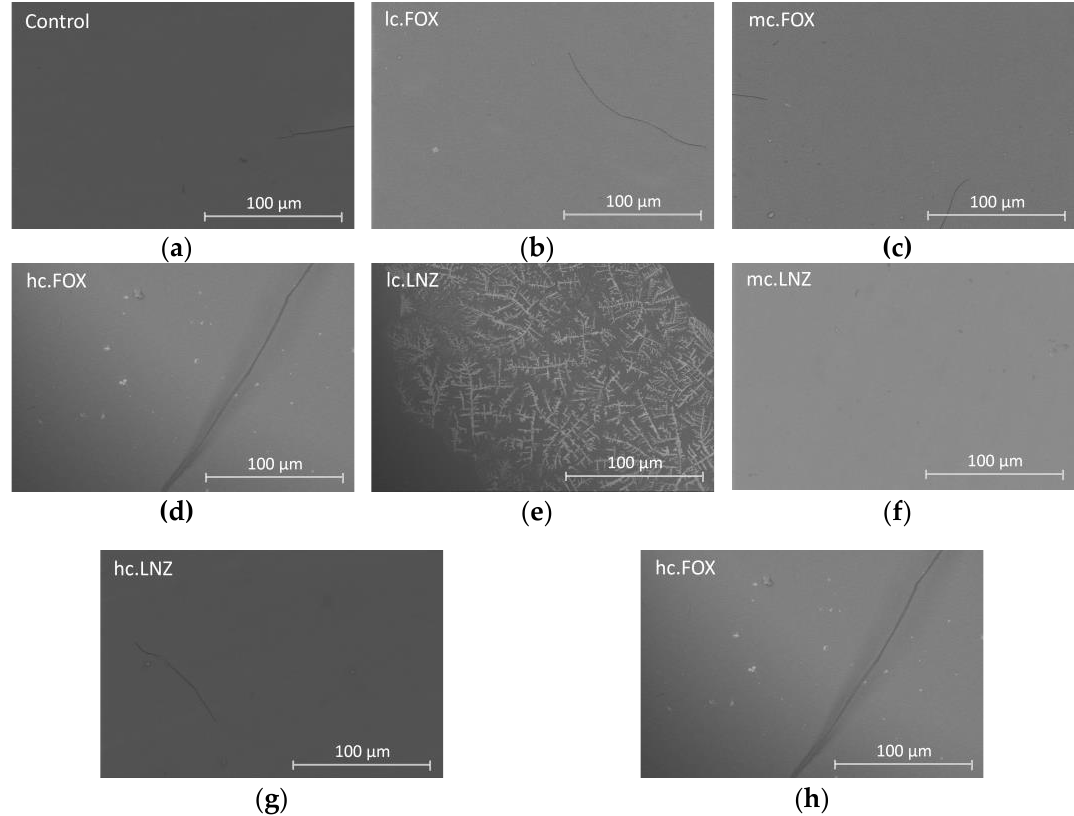
Figure 5. Micrographs obtained with CBS detector by SEM of the ( a ) Control, ( b ) lc.FOX, ( c ) mc.FOX, ( d ) hc.FOX, ( e ) lc.LNZ, ( f ) mc.LNZ, ( g ) hc.LNZ, and ( h ) hc.FOX-LNZ coatings after 24 h of immersion in PBS at 37 °C.